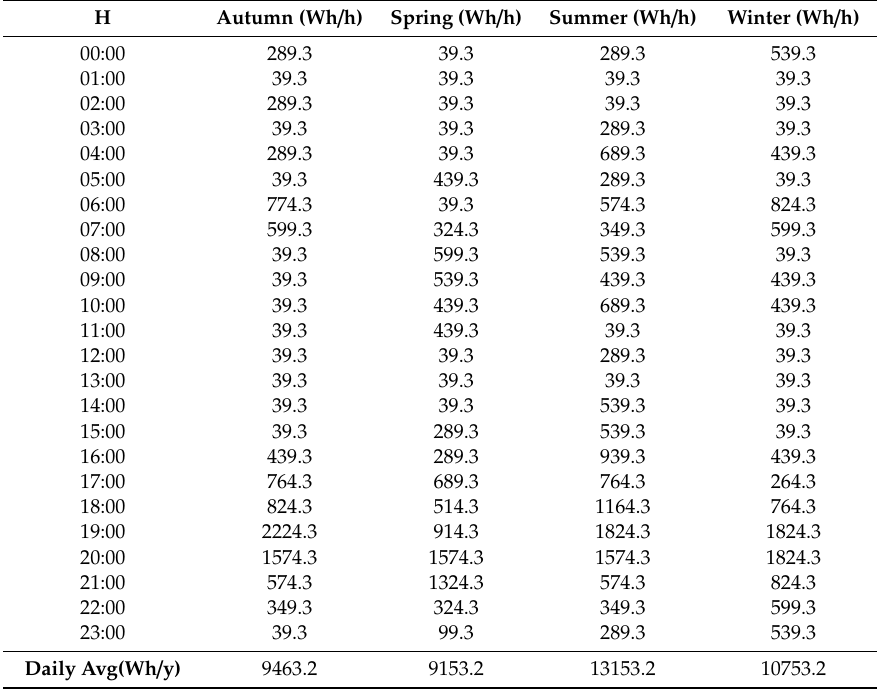
Table 5. Seasonal daily consumption of a household case